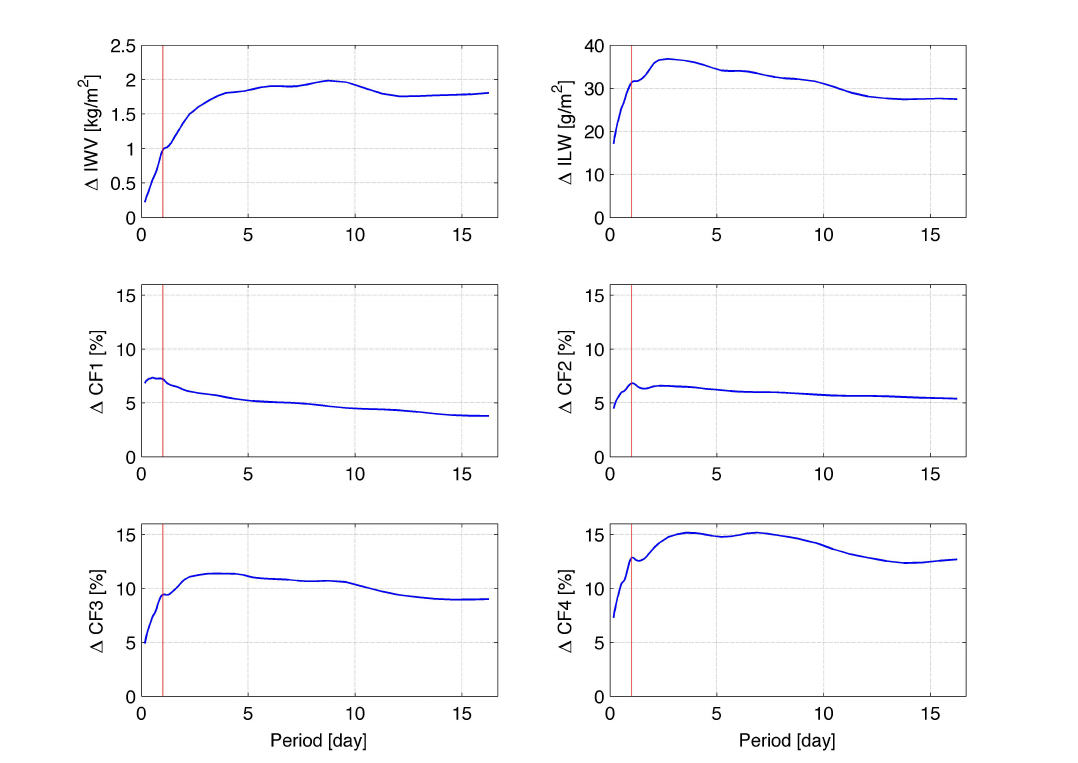
Figure 4. Amplitude spectra of IWV, ILW and CF over Bern for the time interval 2004–2016 obtained by a fast response bandpass filter. The red line marks the position of the diurnal cycle. The short-term variability of fluctuations with periods <10 days is high for ILW and